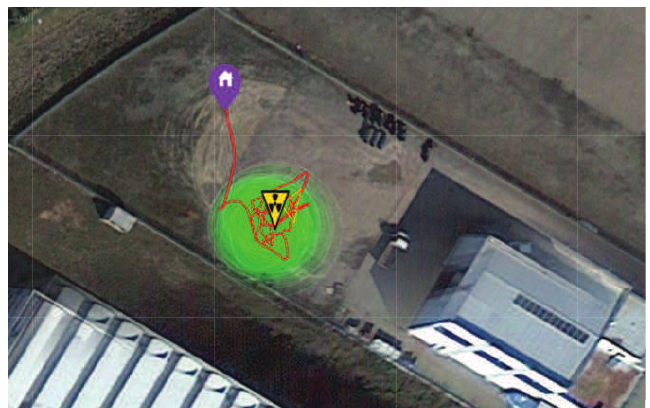
Figure 10. Detection of 192 Ir in a real environment with heading-based teleoperation mode (the operator has direct sight of the nuclear source): image during the exploration task (left). Total radiation spectrum obtained by summing up all measurements (right). A video of the experiment is available as Supplementary Material (video1).